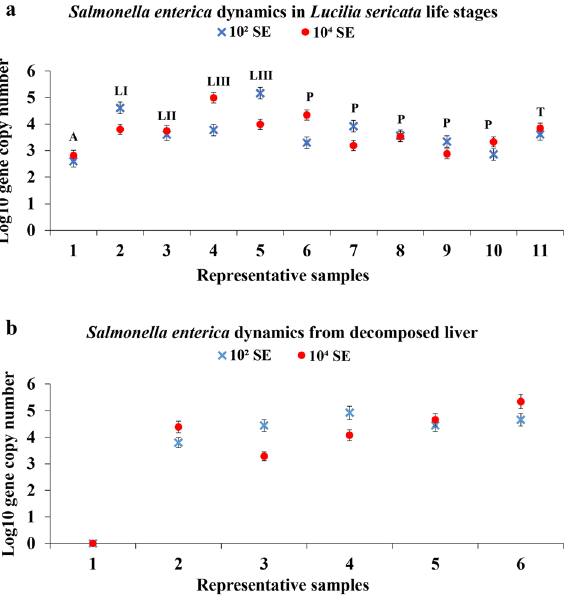
Figure 1. Relative abundance of Salmonella enterica throughout ( a ) Lucilia sericata life stages ( A adult, LI first instar larvae, LII second instar larvae, LIII third instar larvae, P pupa, T teneral specimen) and from ( b ) decomposed liver. Standard deviations are indicated by error bars ( n =